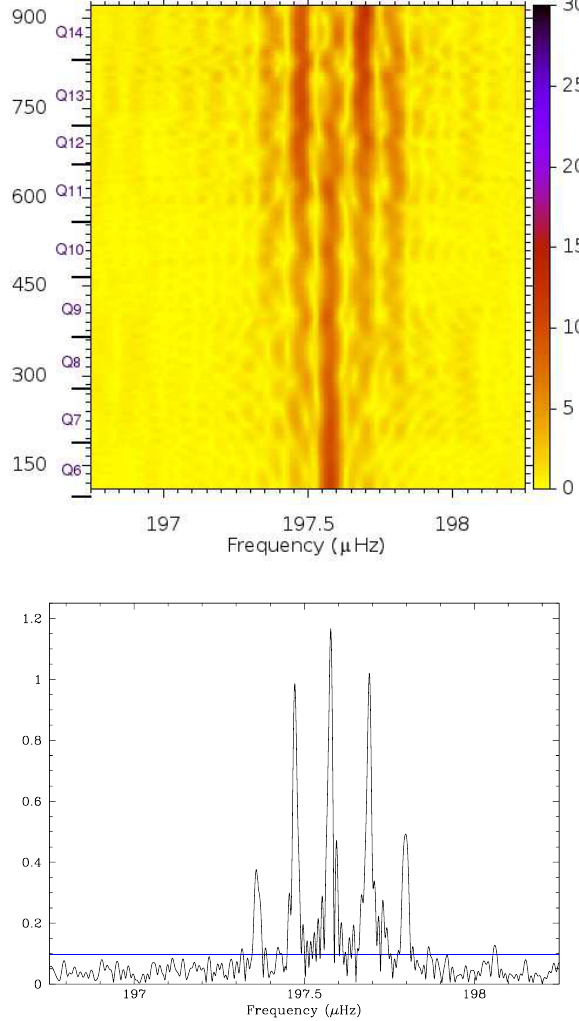
Figure 2. Sliding Fourier transforms (sFTs; top panel) shown with the FT (bottom) of the total data set. Figures from Reed et al. (2014).